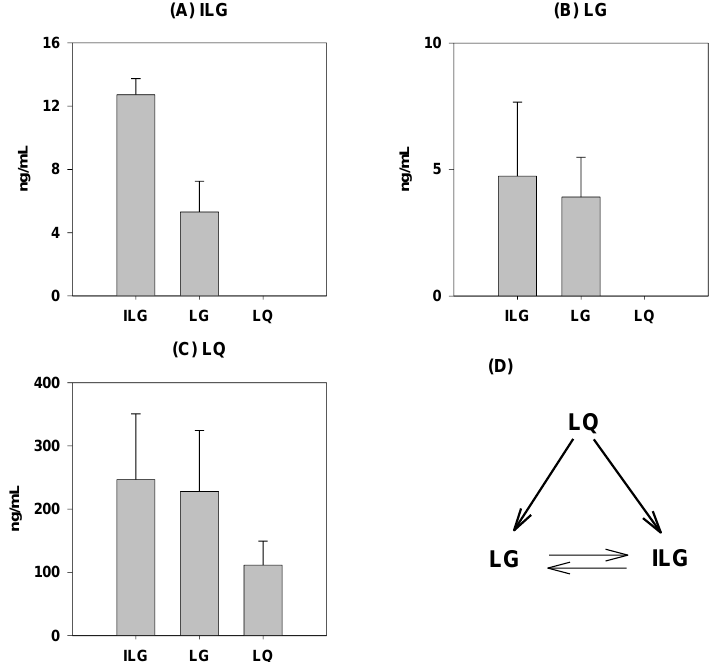
Figure 6. Formation of isoliquiritigenin (ILG), liquiritigenin (LG), and liquiritin (LQ) 2 h incubation after the addition of ( A ) isoliquiritigenin (ILG), ( B ) liquiritigenin (LG), and ( C ) liquiritin (LQ) in rat ileum. ( D ) Proposed biotransformation scheme among LQ, LG, and ILG in rat intestine. Data were expressed as mean ± SD from six independent experiments per group.